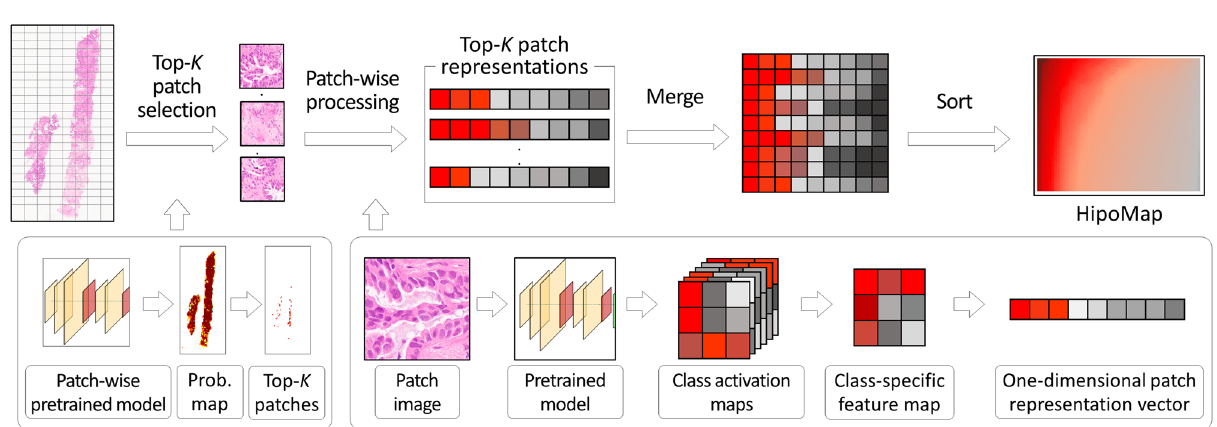
Figure 3. Overview of HipoMap. The proposed method produces a HipoMap that represents a whole slide image through (1) top- K patch selection, (2) patch-wise representation, and (3) patch